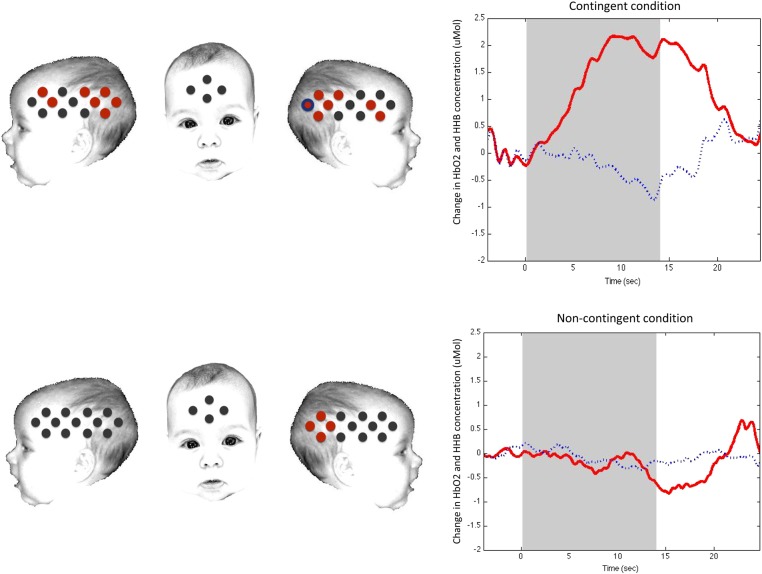
A schematic view of the fNIRS arrays with channels showing a significant increase in HbO2 during (a) the contingent condition compared with baseline and (b) the non-contingent condition compared with baseline (time window 10–18 s) in Experiment 2. Channels colored in red show a significant increase in HbO2, whereas channels in blue show a significant decrease in HHb concentration. The concomitant presence of the 2 colors highlights a simultaneous significant increase in HbO2 and a significant decrease in HHb. Time courses on the right of the figure show HbO2 activation (in red) and HHb activation (in blue), in channel 26 during the contingent (top panel) and non-contingent (lower panel) conditions. Note that standard analysis is shown. The schematic is used for illustrative purposes only.